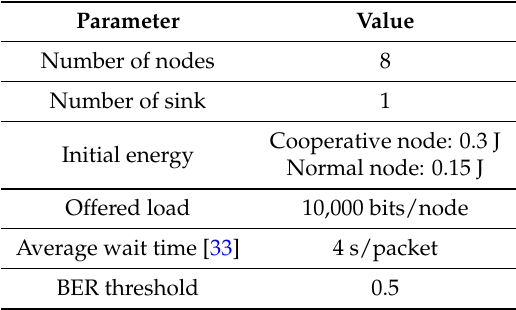
Table 6. Simulation parameters for WBAN